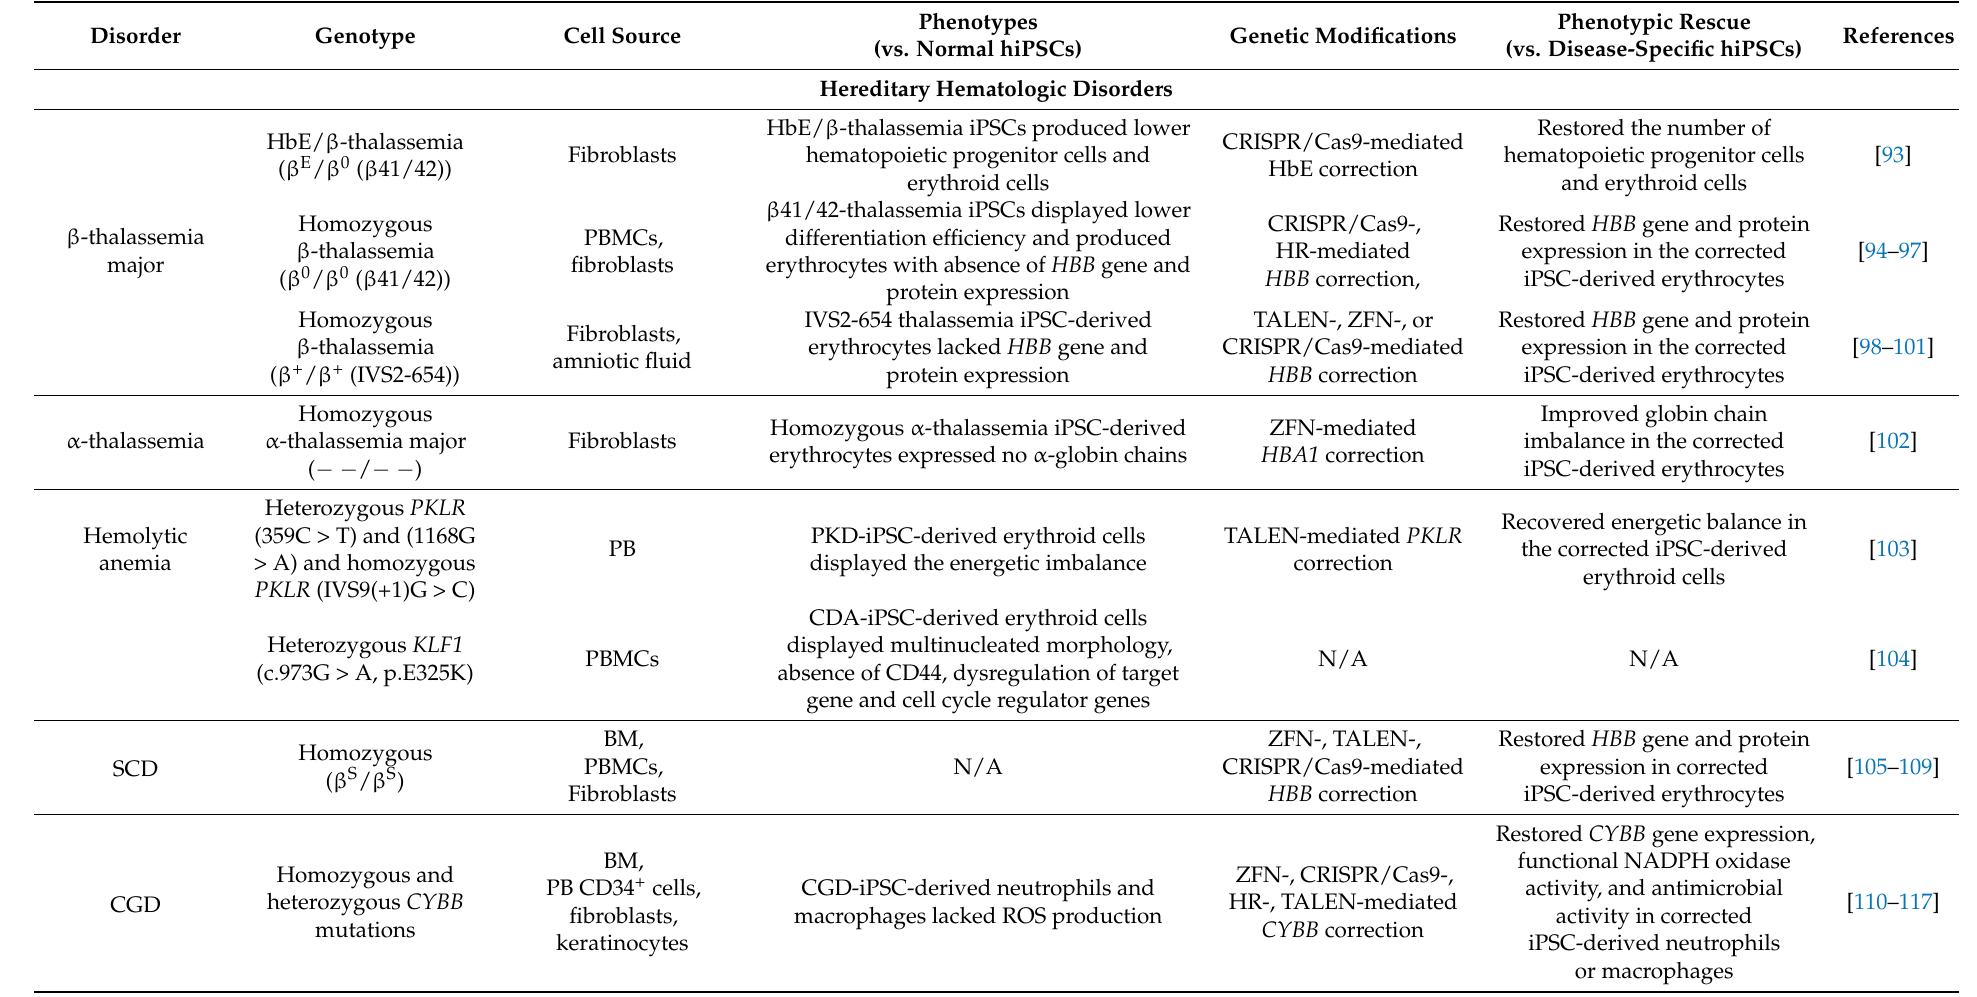
Table 1. List of the selected studies using hiPSCs for genetic disease modeling for hereditary and acquired hematologic